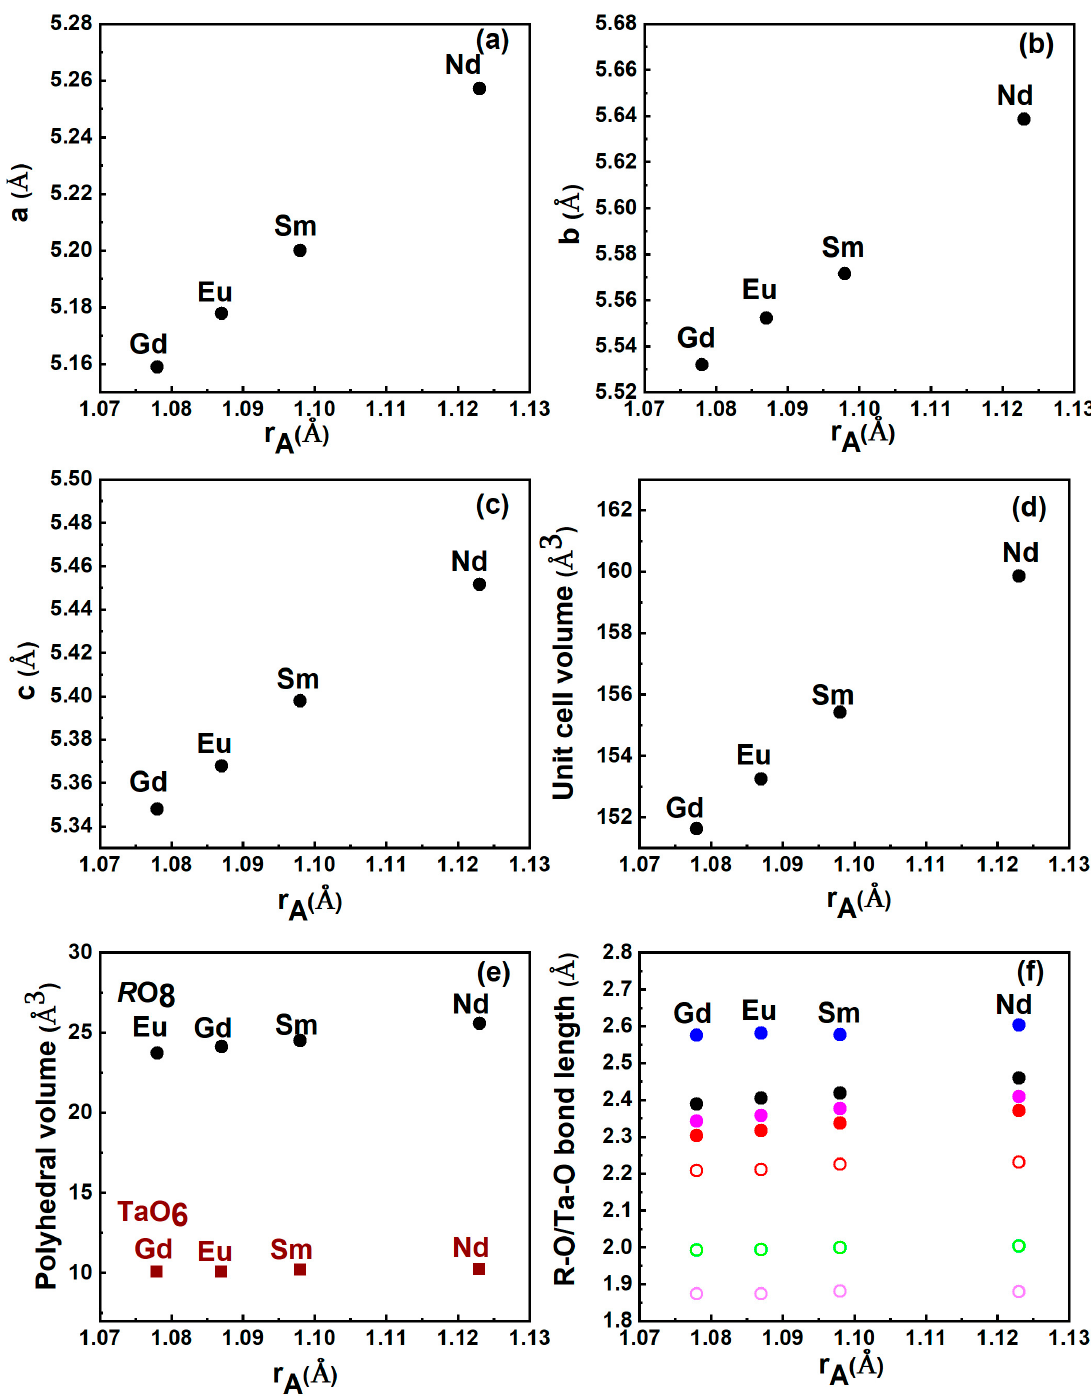
Figure 2. Dependence of lattice parameters: ( a ) a , ( b ) b , ( c ) c , ( d ) unit cell volume V , ( e ) constituent polyhedral volume and ( f ) interatomic distances with the ionic radii of the lanthanide cation (Gd, Eu, Sm, and Nd).